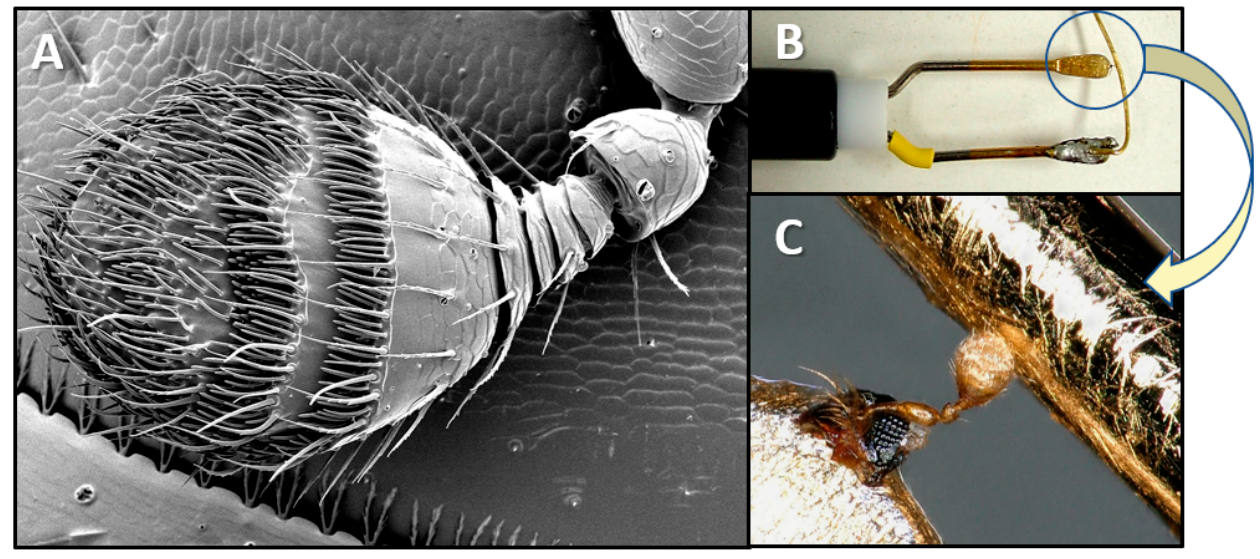
Figure 2. Antenna of female Euwallacea perbrevis. ( A ) Scanning electron micrograph; credit: Gary Bauchan, USDA-ARS. ( B ) Two-pronged EAG antennal holder modified with gold wire to accommodate the small antenna of E. perbrevis , mounted within the circled region. ( C ) Magnified region from panel B to show antennal preparation used for EAG recordings.